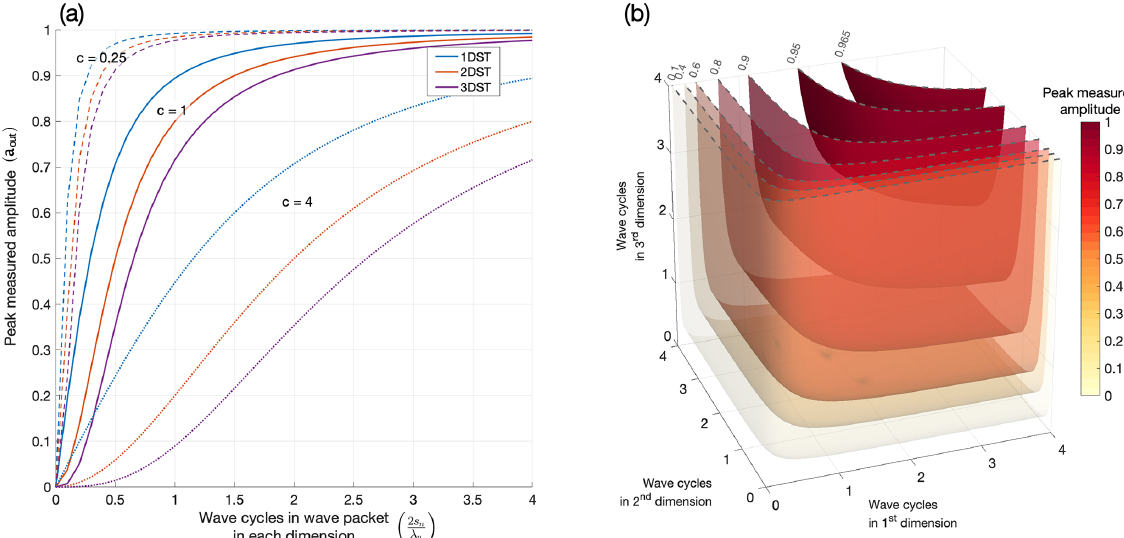
in each dimension for any given wave packet. Panel λ n